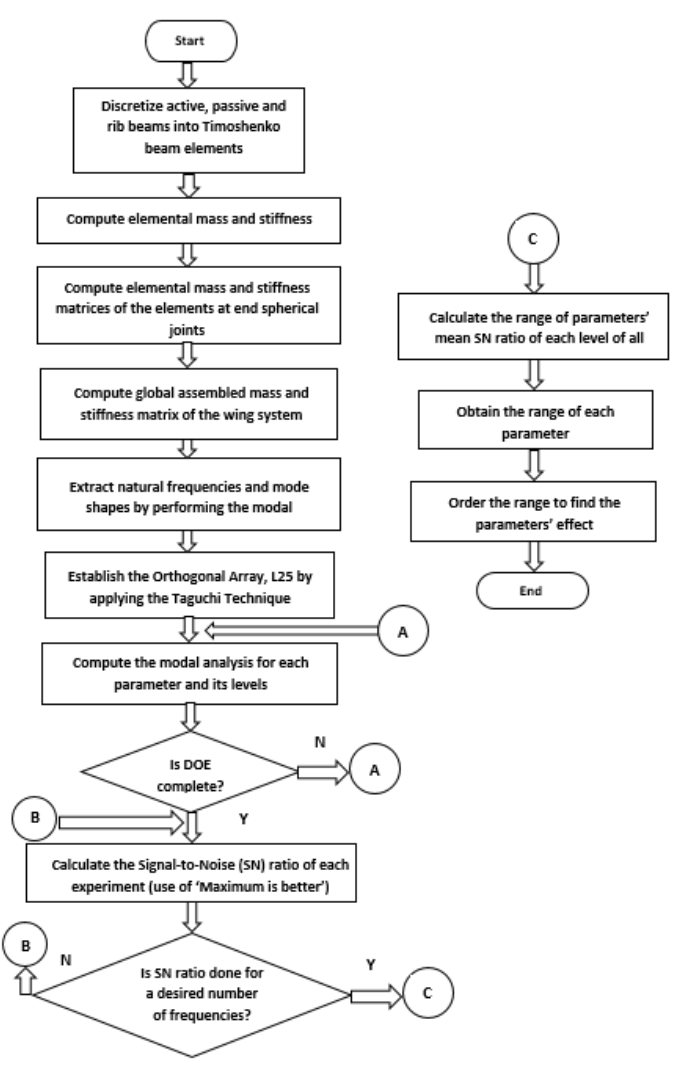
Figure 5. Flowchart of the numerical simulations.